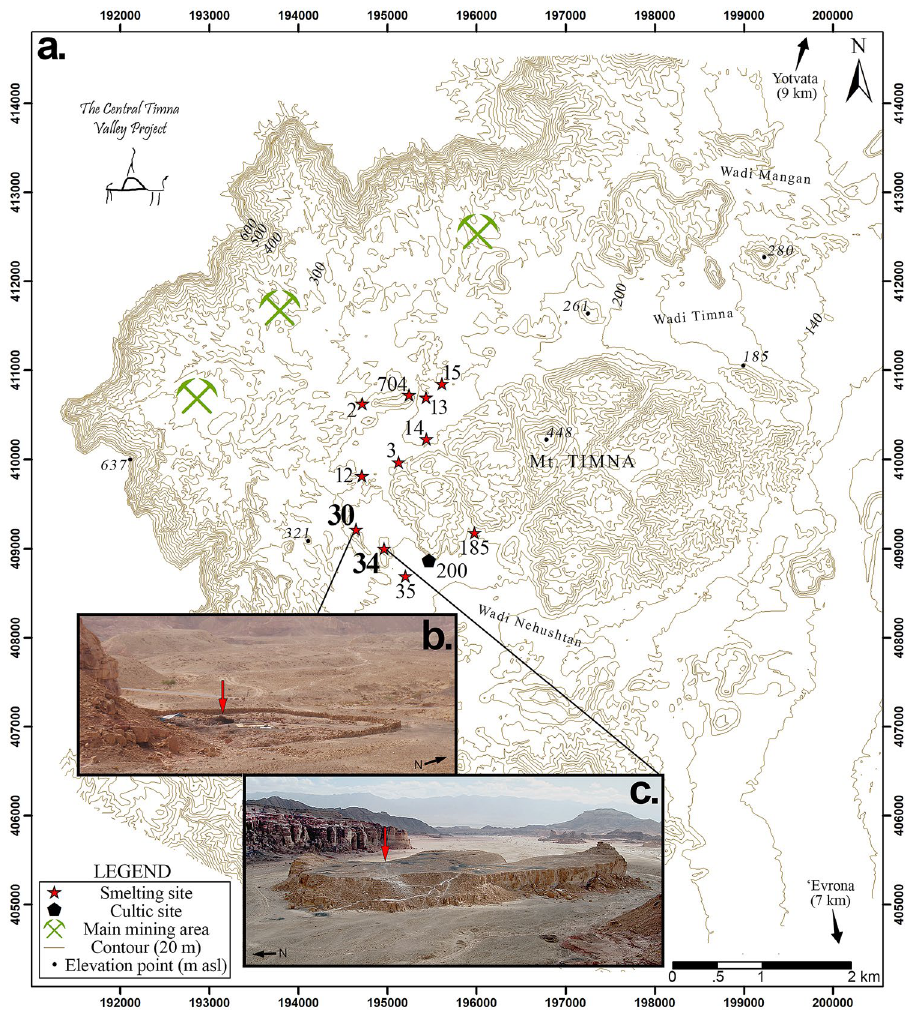
Figure 2. Map of Iron Age Timna Valley and images of Sites 30 and 34. ( a ) Map of the Timna Valley as it appeared in the Iron Age with views of ( b ) smelting site Site 30 5: Fig. 2 and ( c ). smelting site Site 34/ “Slaves Hill” 6: Fig. 3 . Red arrows indicate location of Slag Mound S at Site 30 and Slag Mound 19 at Site 34. Map generated using ArcGIS for Desktop V.10.4.1 (www. esri. com) and modified using Adobe Photoshop 2020 ver. 21.1 [www. Adobe. com]. Photos taken by E.